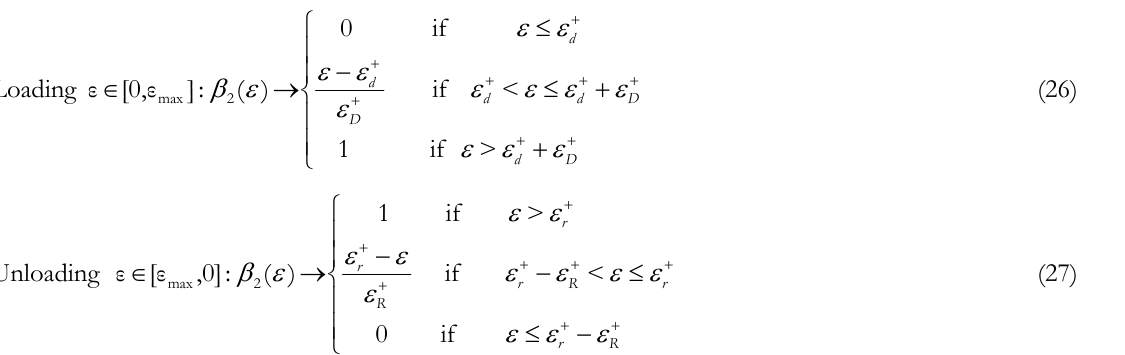
T (a) and at the low temperature T 2 1